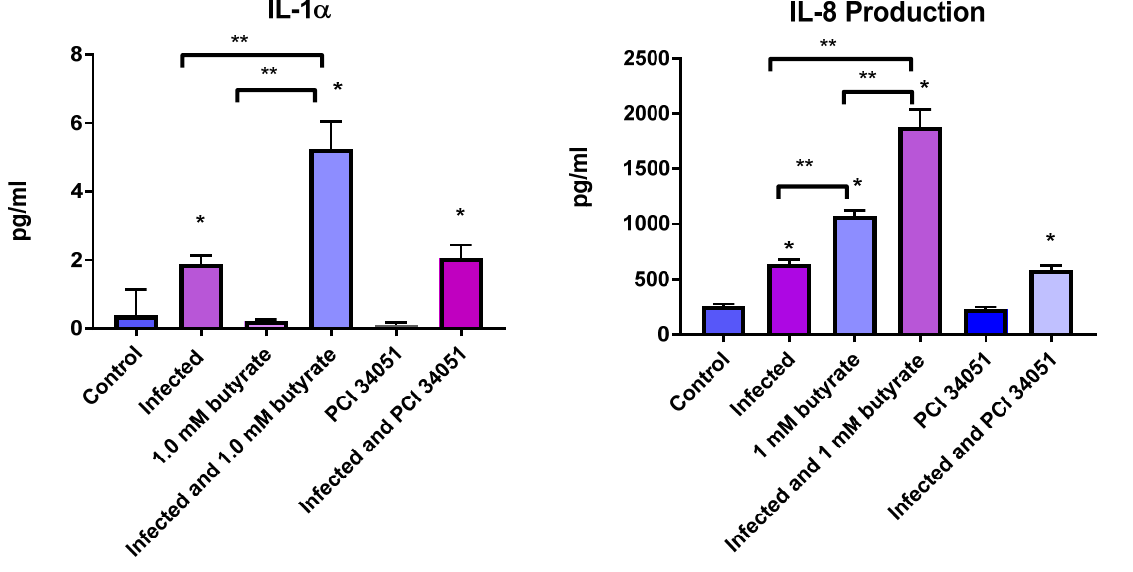
Figure 1. Effects of short-chain fatty acids on cytokine expression. HCT-8 cells were infected with C. parvum and/or treated with 1 mM butyrate for 48 h, after which supernatants were analyzed for cytokine production using the Luminex 100 system (Luminex). Amounts of cytokines, IL-1 α ( left figure ) and IL-8 ( right figure ) are shown above. Values are reported as relative light units. Control wells (uninfected, untreated) were compared with treated and infected wells. Values are means ± SEM, n = 4. * Different from control, p < 0.05. ** Different from the experimental group as indicated by bar, p <